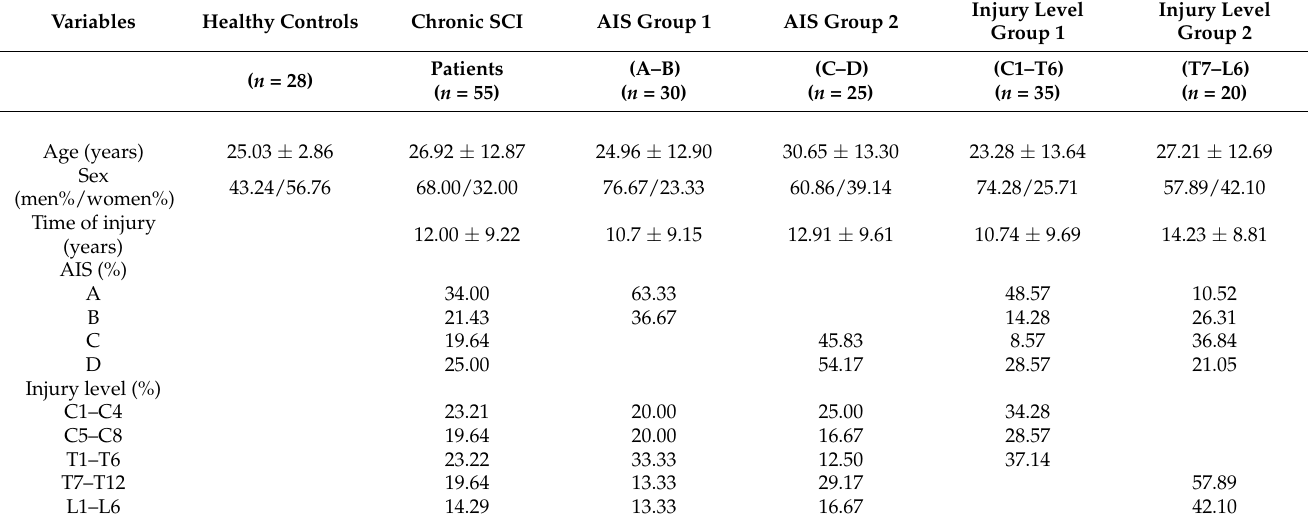
Table 1. Demographic, clinical and biological data of the patients and healthy